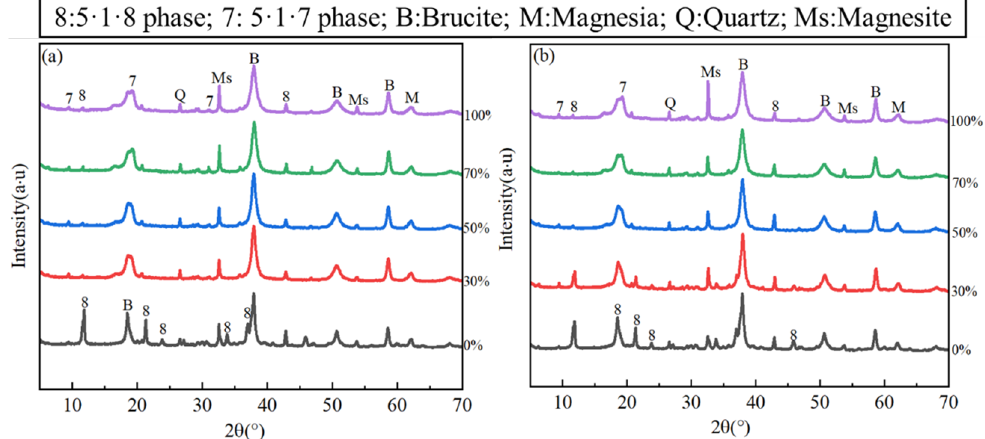
Figure 5. The XRD patterns of cement with different mass fractions of MgSO 4 ( a ): Air curing for 28 days; ( b ): Water immersion for 28 days.